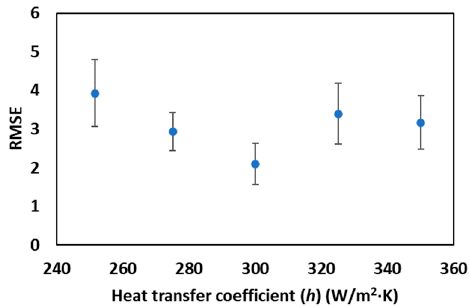
Figure 4. Average RMSE for three BF samples with different amounts of BF in the pouch depending on h .